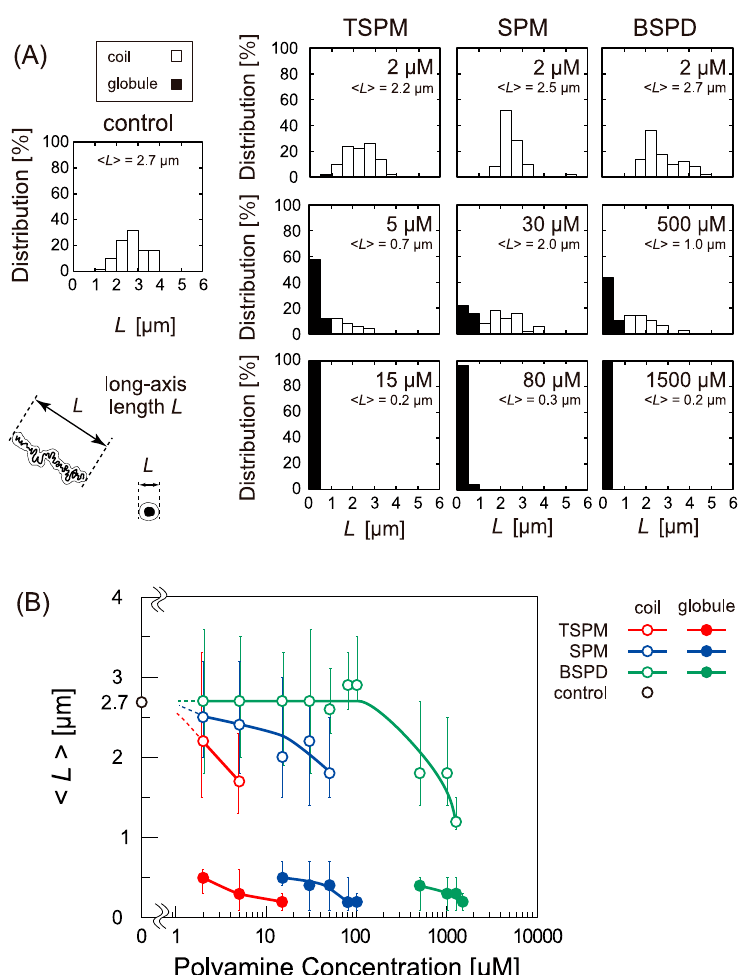
Figure 2. ( A ) Histograms of the long-axis length L of T4 GT7 DNA evaluated through FM observations at different concentrations of the polyamines TSPM, SPM, and BSPD. For each condition, 50 DNA molecules were measured. The DNA concentration was 0.1 µ M in nucleotide units. ( B ) Ensemble average < L > of the long-axis length of T4 GT7 DNA. The distribution widths of L due to Brownian motion are depicted with thin vertical lines. The populations in the coil and globule states are indicated by white and black bars in the histogram.